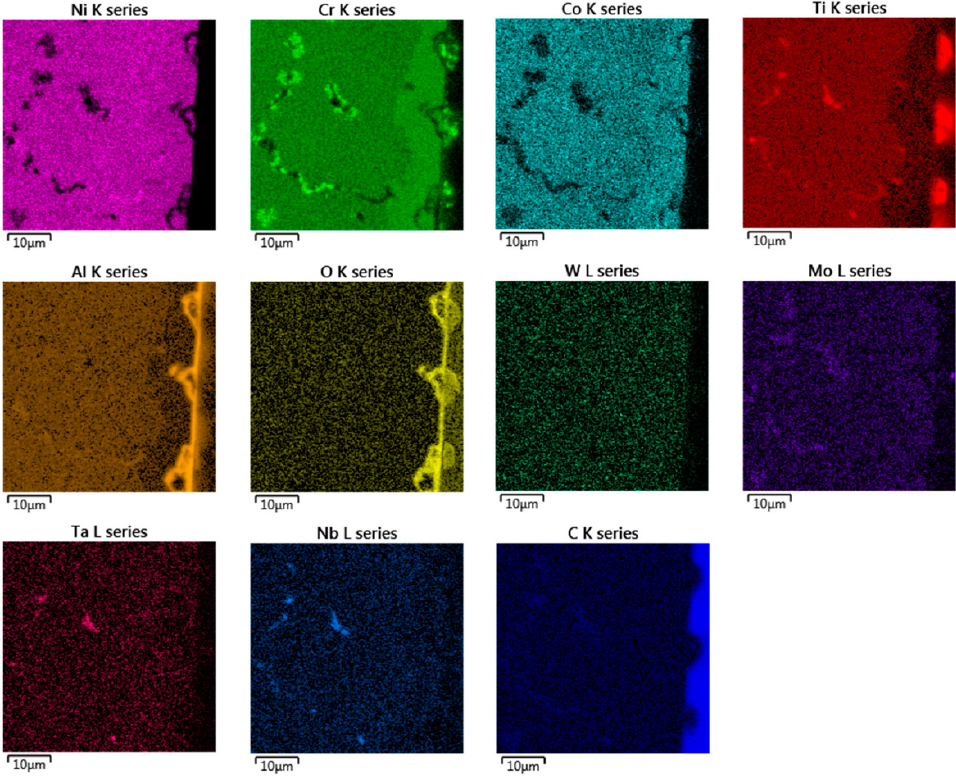
Figure 6. EDX chemical mapping of IN738—100R after exposure to He.